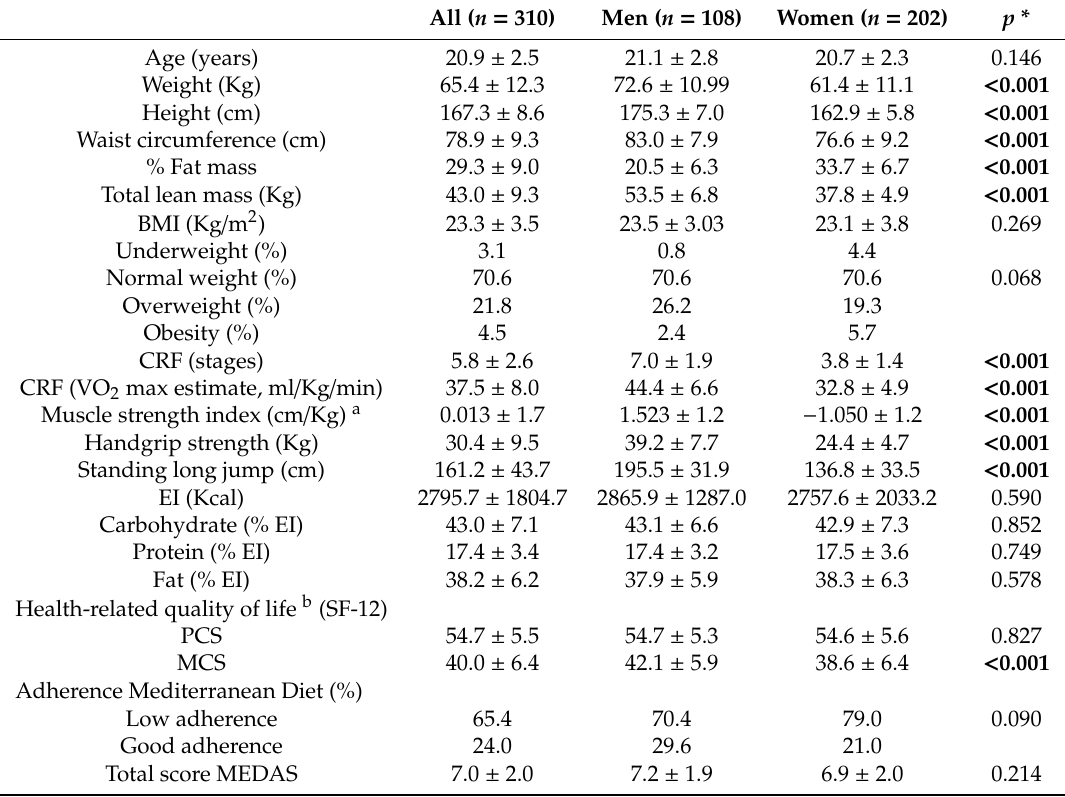
Table 1. Descriptive characteristics of the study sample by